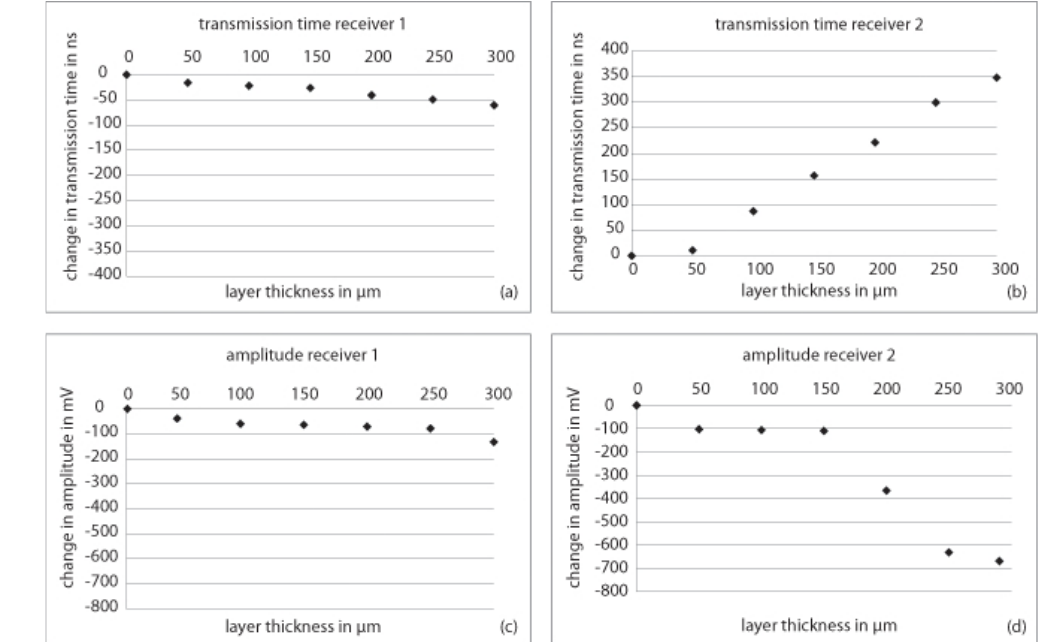
Figure 17. Measurement results of adhesive tape of di ff erent thicknesses in the tube for the changes of the transmission times and amplitudes of the acoustic signals on the emitter wall and through the liquid. The standard deviation is too small to be drawn in.